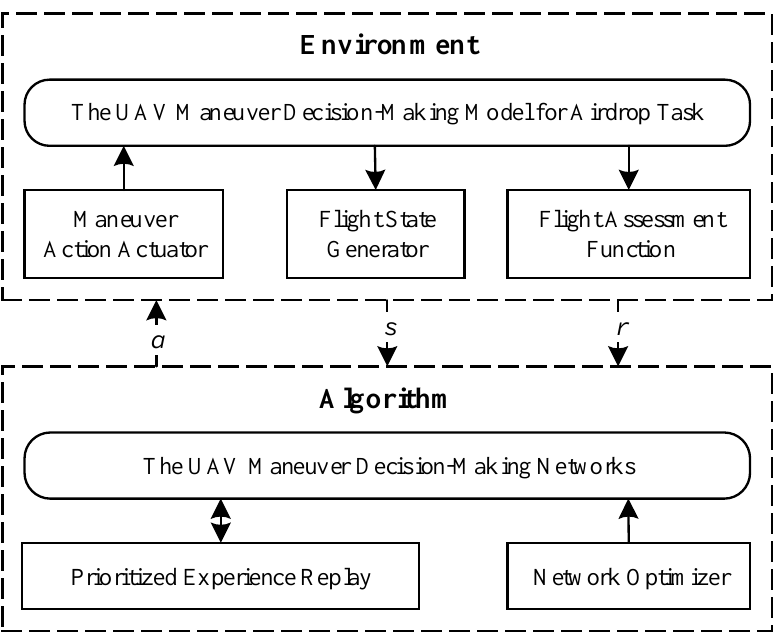
Figure 1. The structure of unmanned aerial vehicle (UAV) Maneuver Decision-Making